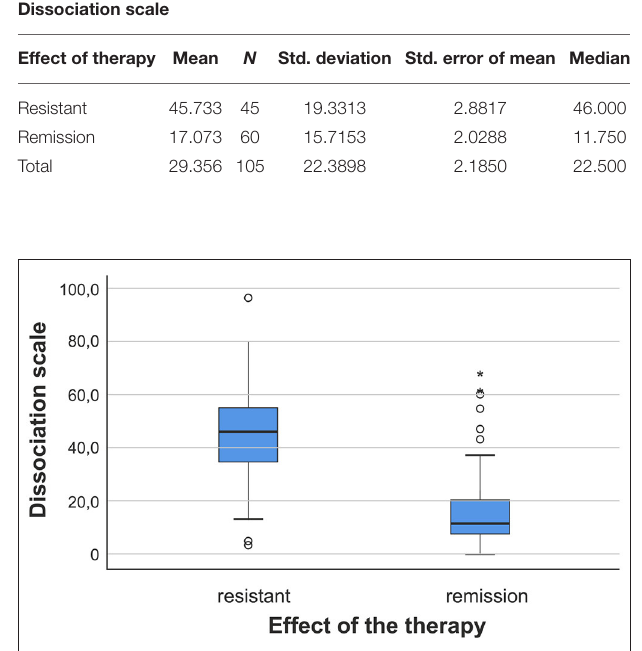
FIGURE 1 | The variance of the results measured with DES in both groups of patients. The variance—in